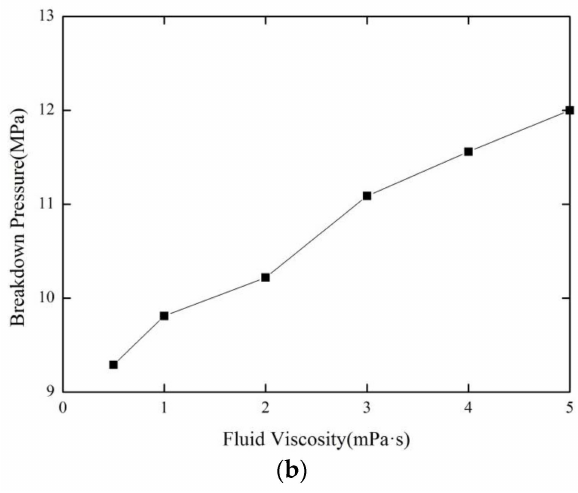
Figure 11. The relationship between hydraulic fracturing characteristics and injection fluid viscosity. ( a ) The relationship between maximum aperture and fluid viscosity; ( b ) The relationship between breakdown pressure and fluid viscosity.